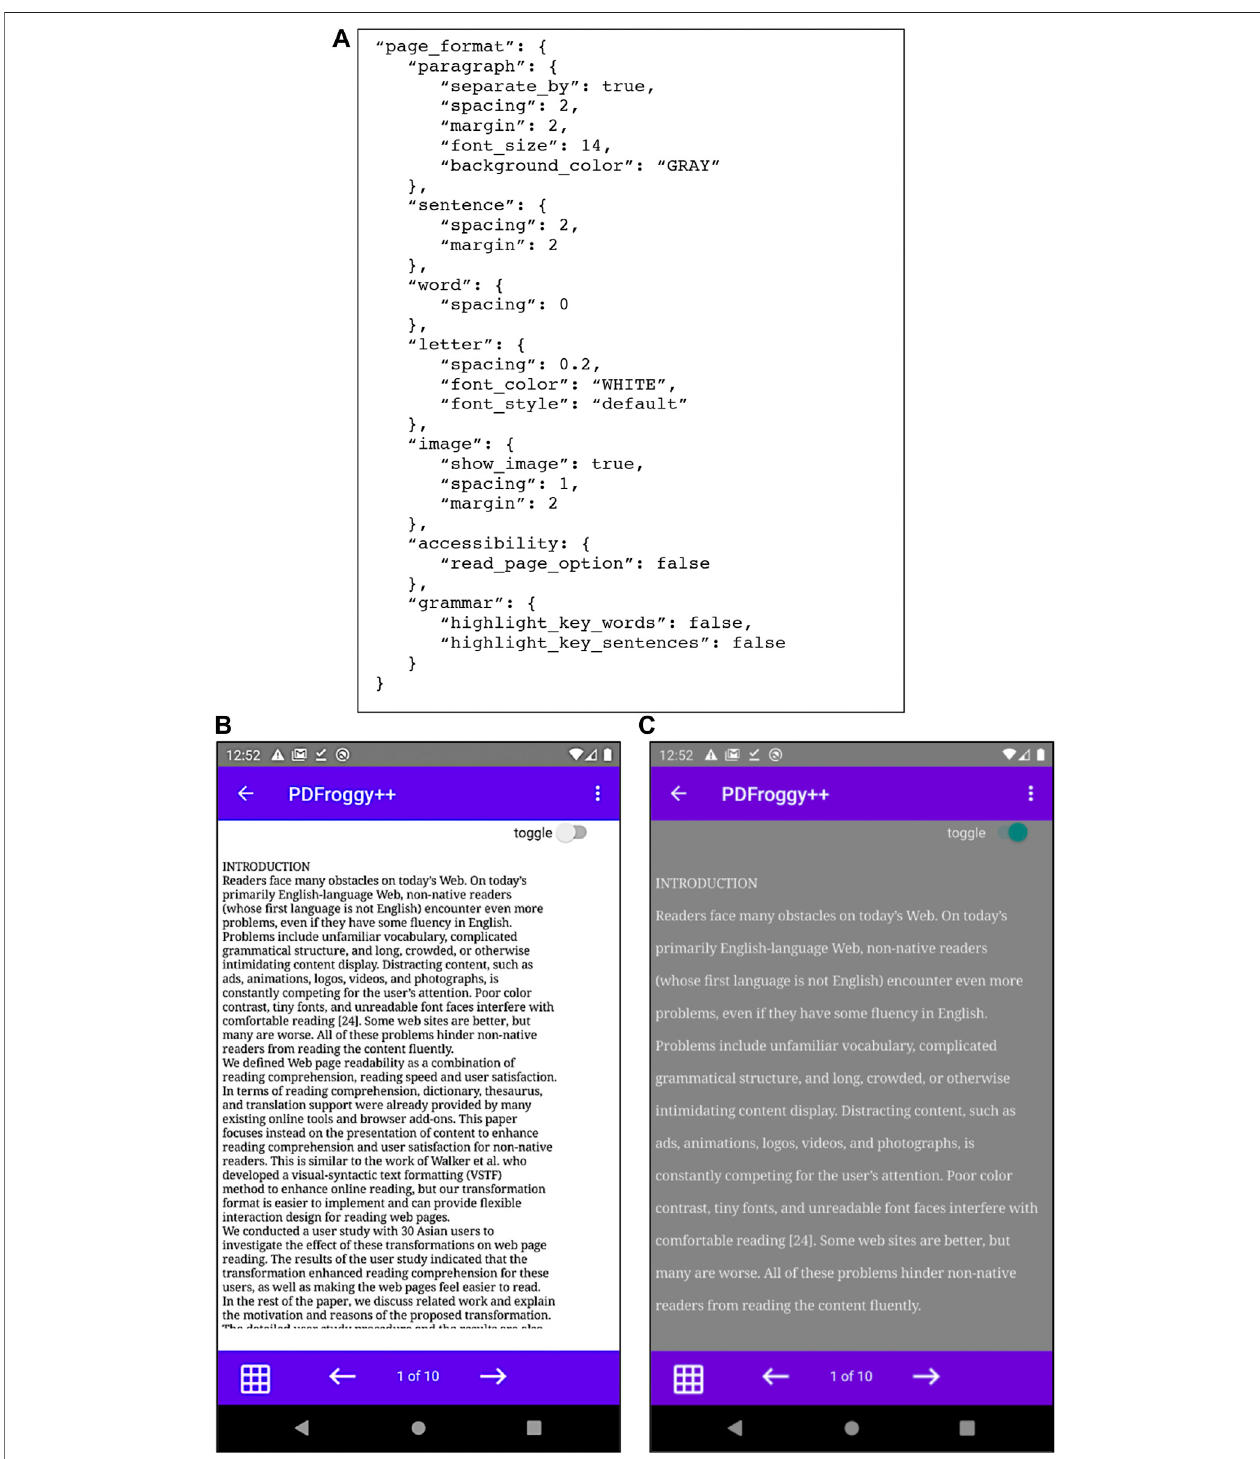
FIGURE 9 | (A) An example of page formatting JSON fi le; (B) Original PDF view; (C) Formatted content.